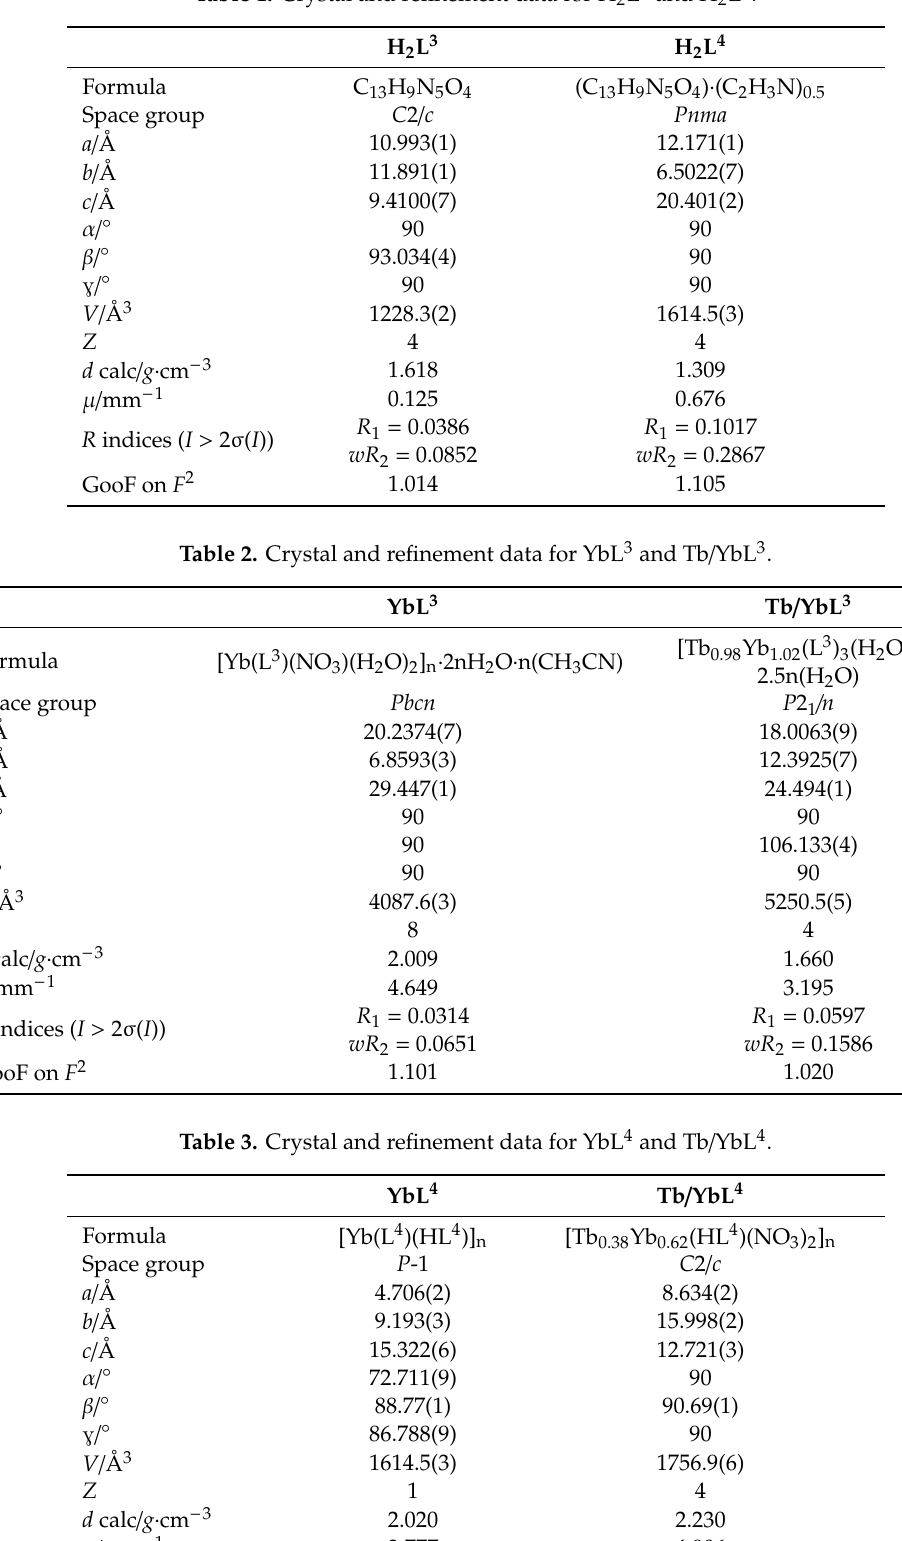
Table 1. Crystal and refinement data for H 2 L 3 and H 2 L 4 .